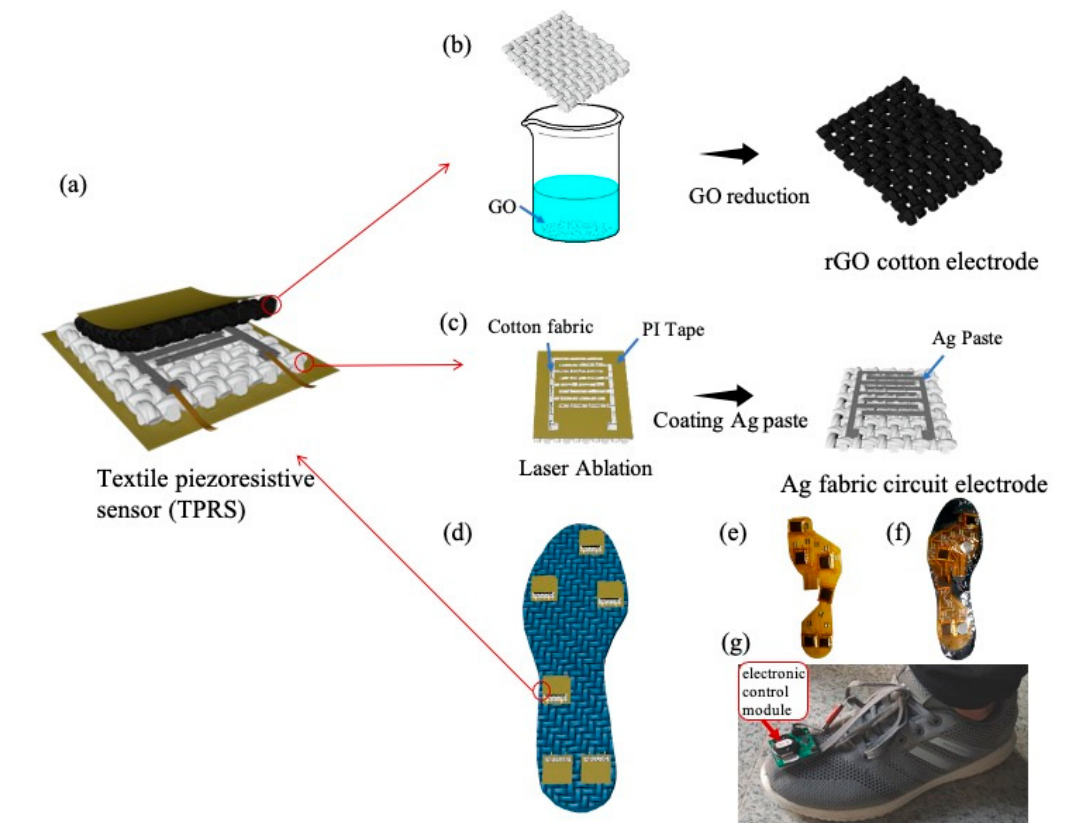
Figure 1. Schematic illustration of fabric electrodes and textile piezoresistive sensor (TPRS): ( a ) the preparation process of the fabric electrode coated with silver paste; ( b ) the preparation process of the fabric electrode coated with reduced graphene oxide (rGO); ( c ) the assembly process with Polyimide (PI) tape; ( d ) the preparation process of the complete TPRS, ( e ) flexible printed circuit board with attached TPRSs, ( f ) encapsulated insole and ( g ) in-shoe setup.